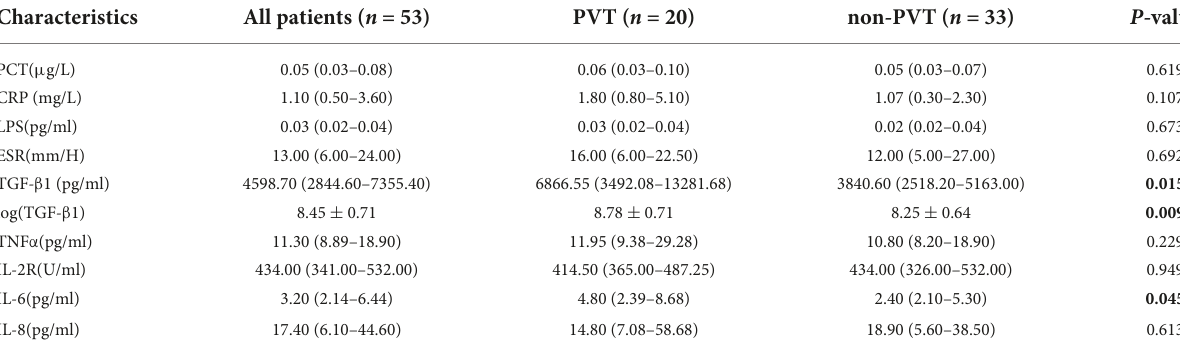
TABLE 2 The comparison of levels of inflammatory cytokines between portal vein thrombosis (PVT) and non-PVT groups.